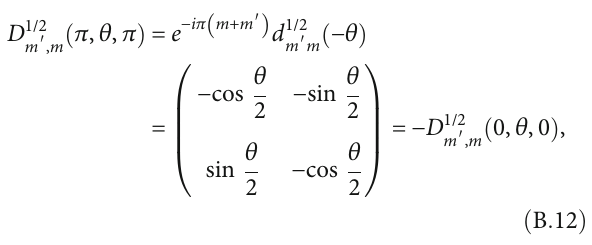
Table 1: Helicity couplings and Breit-Wigner parameter values employed in the numerical study in Section